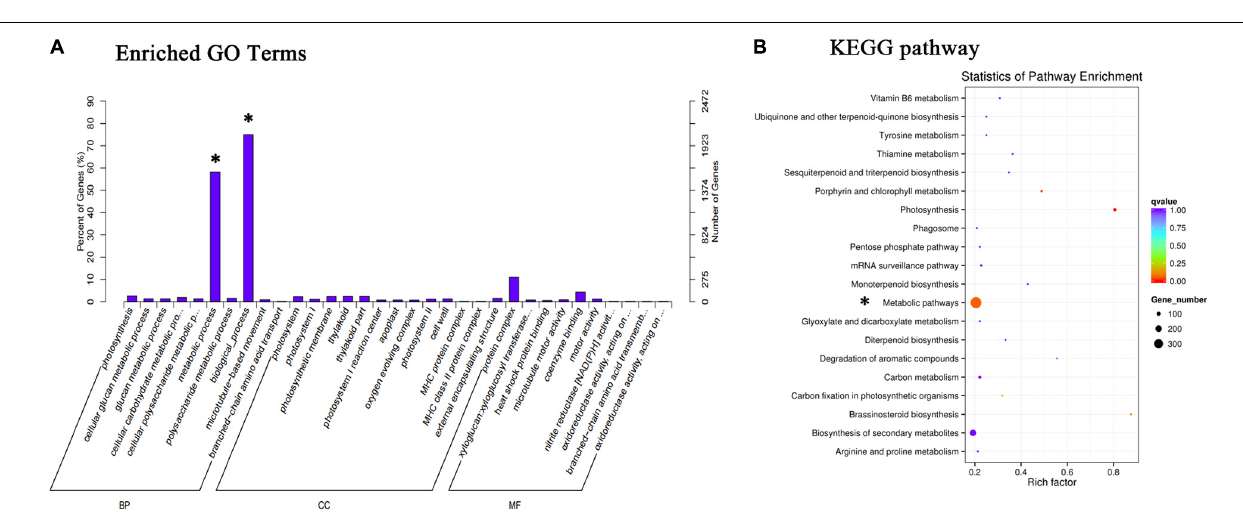
inconsistent. Although the transcripts of DFR differed to